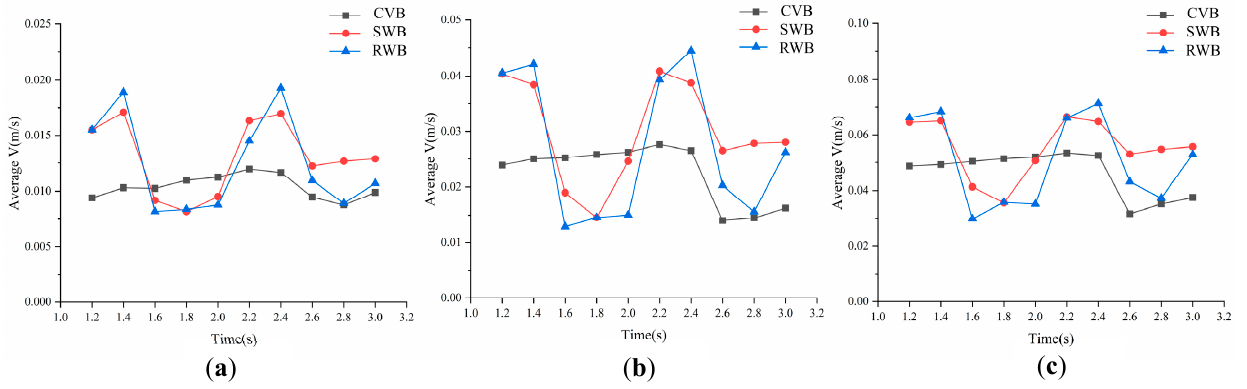
Figure 14. Average velocity on plane 2, plane 4, and plane 6 for two periods: ( a ) Average velocity on plane 2; ( b ) Average velocity on plane 4; ( c ) Average velocity on plane 6.